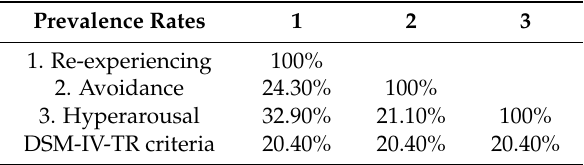
Table 2. Concordance among the different prevalence PTSD symptom